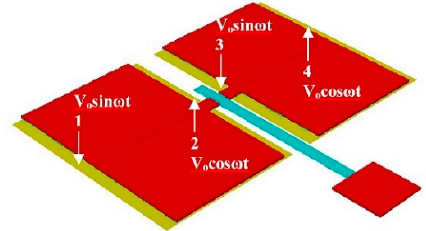
Figure 7. The optimized scanner design with a proof mass of 60 µ m × 60 µ m × 4 µ m, waveguide length